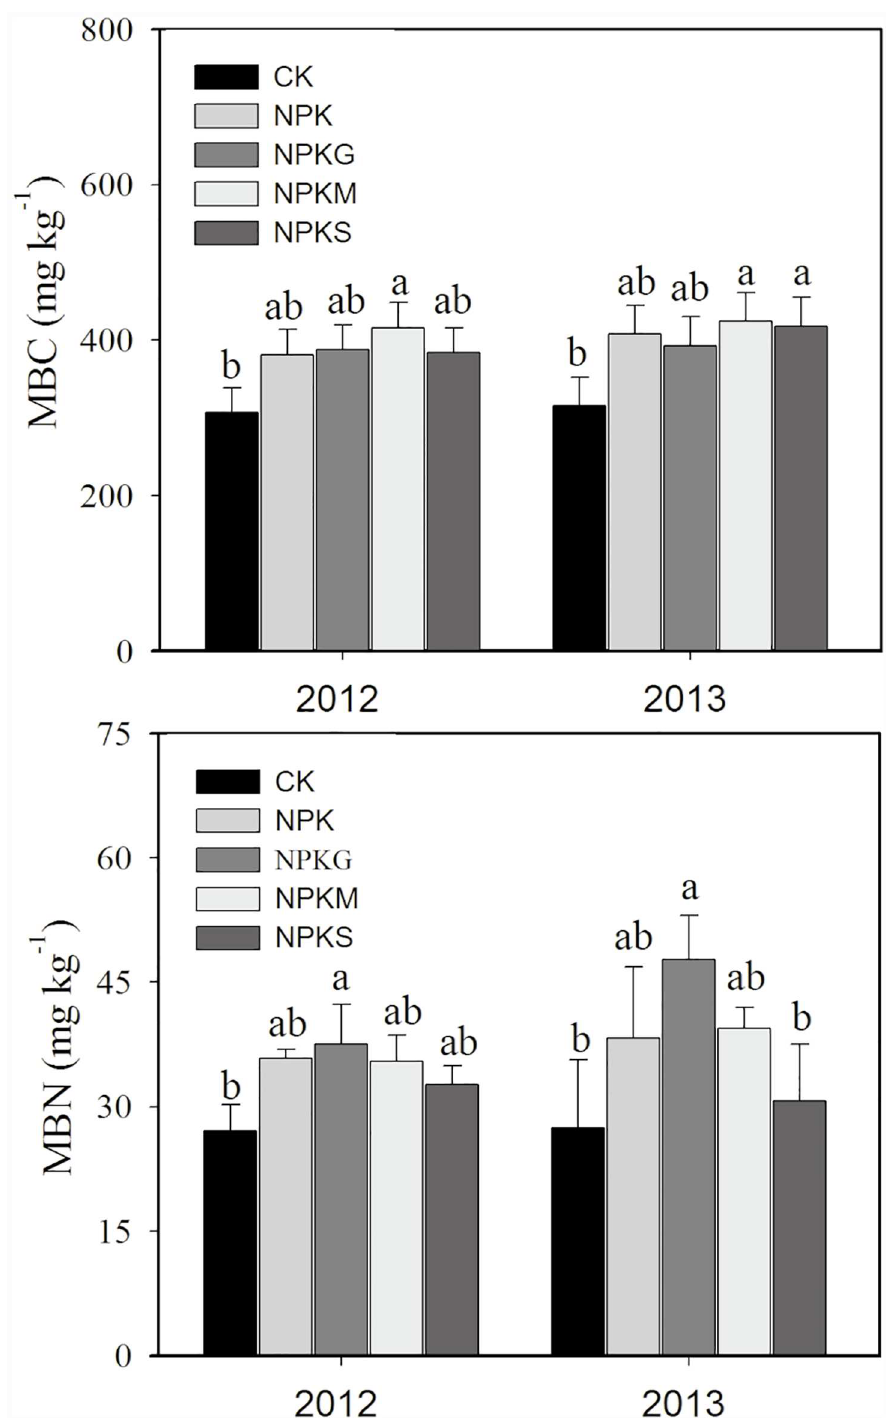
Fig 2. Variations in Microbial Biomass Carbon (MBC) and Nitrogen (MBN) under different fertilizations in 2012 and 2013. Vertical bars represent the SE ( n = 3) and different letters abovebars indicatesignificant differences betweenfertilizations at P <